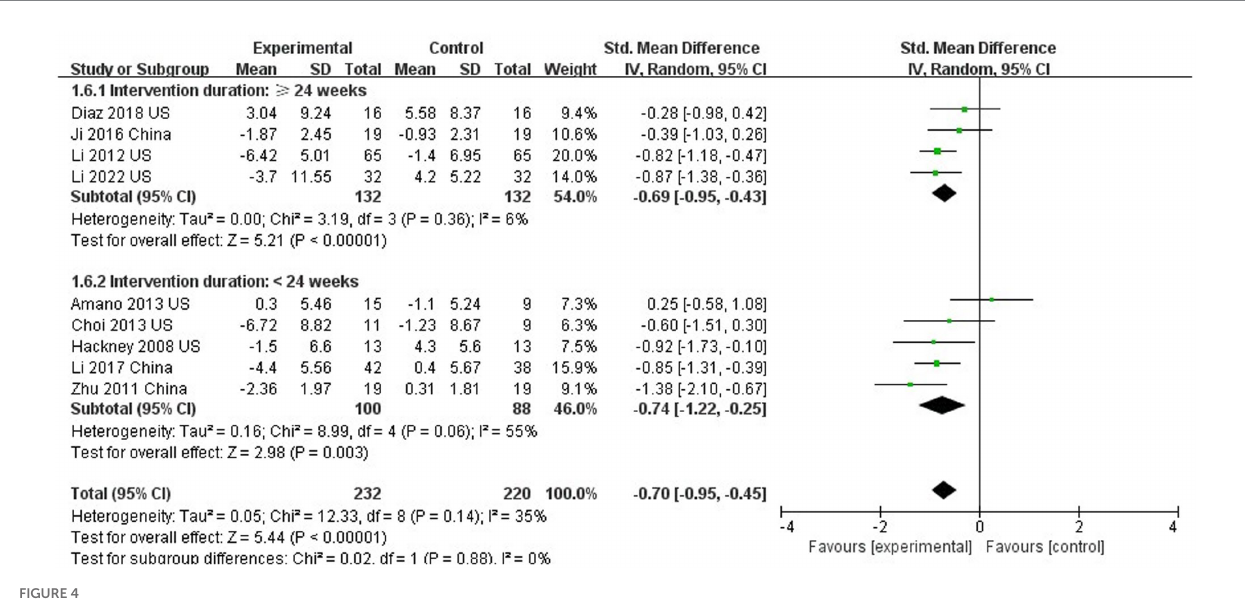
FIGURE 4 Influence of different intervention time on motor function (subgroup